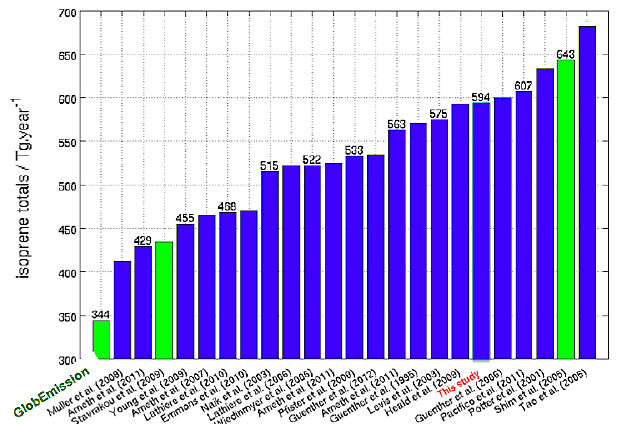
Figure 21. Isoprene global total estimated from different studies. Studies highlighted in green used formaldehyde satellite data and an inversion modelling technique to constrain isoprene emissions (Sindelarova et al.,